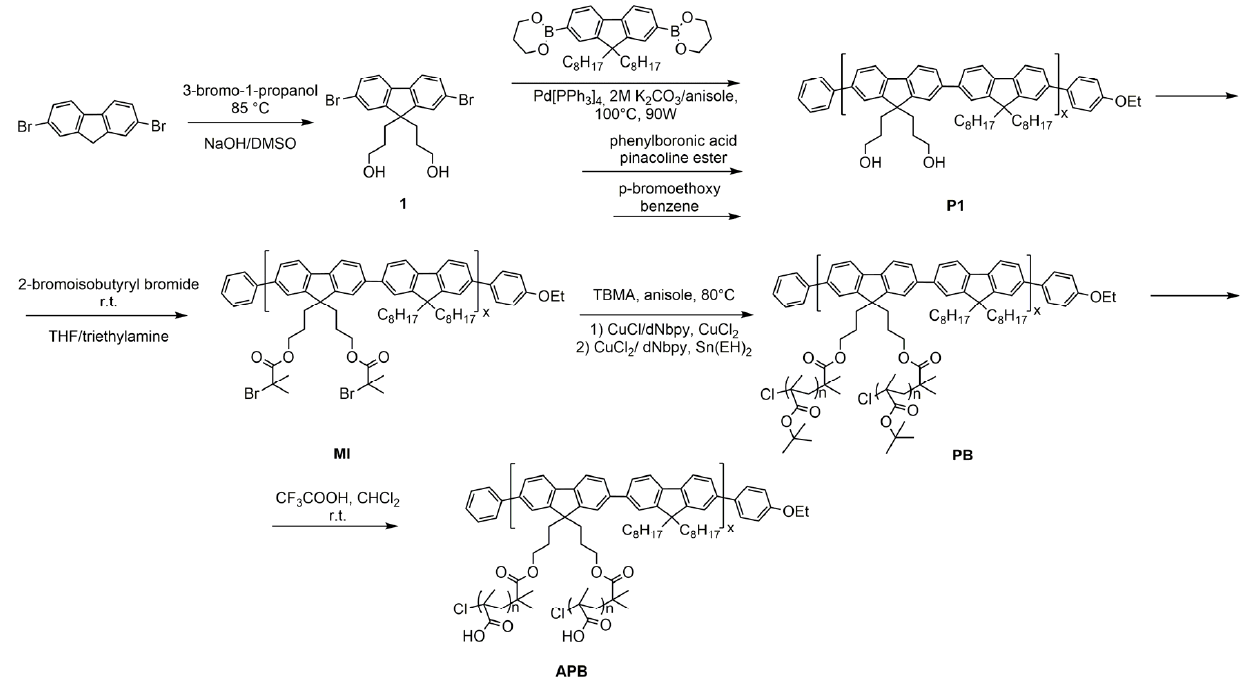
Figure 2. Synthesis of polymer brushes.